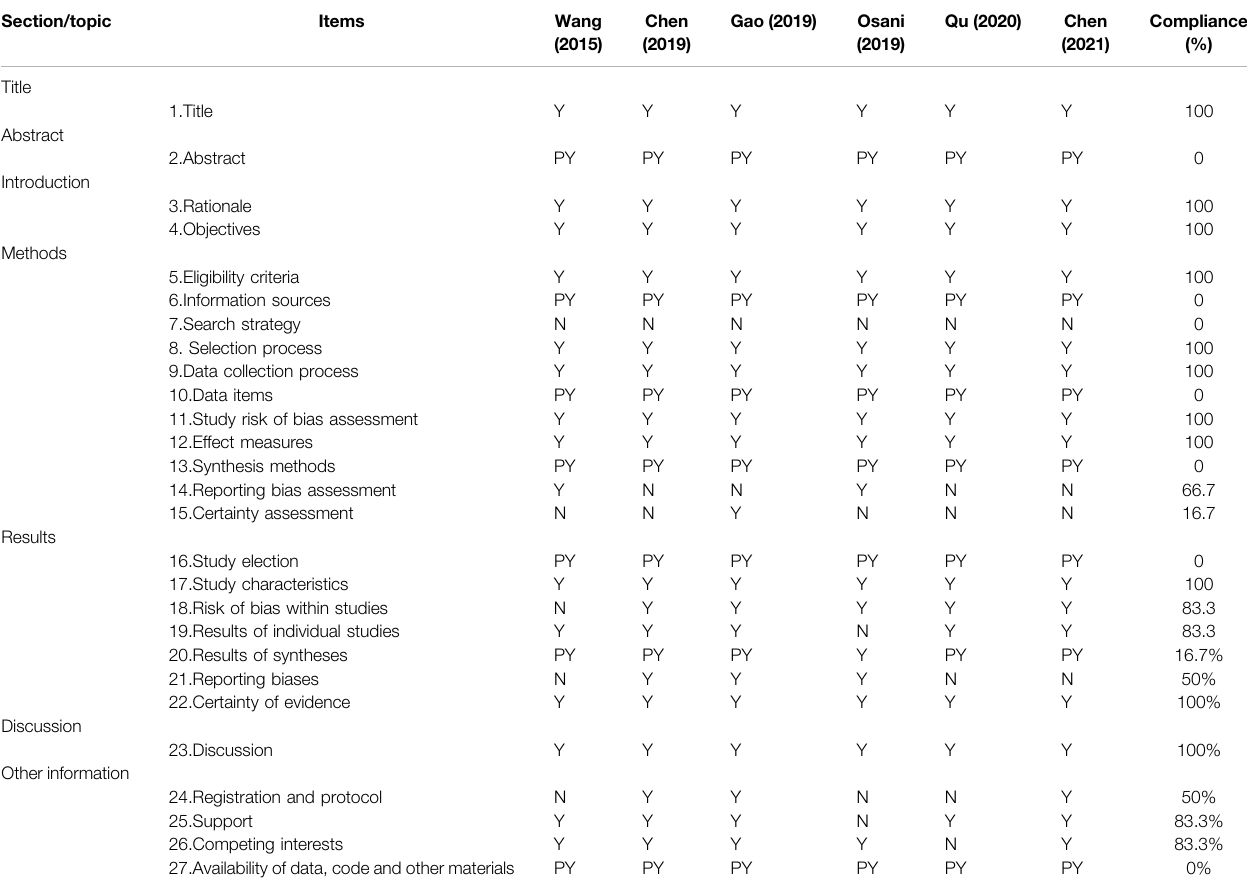
TABLE 5 | Results of the PRISMA assessments.